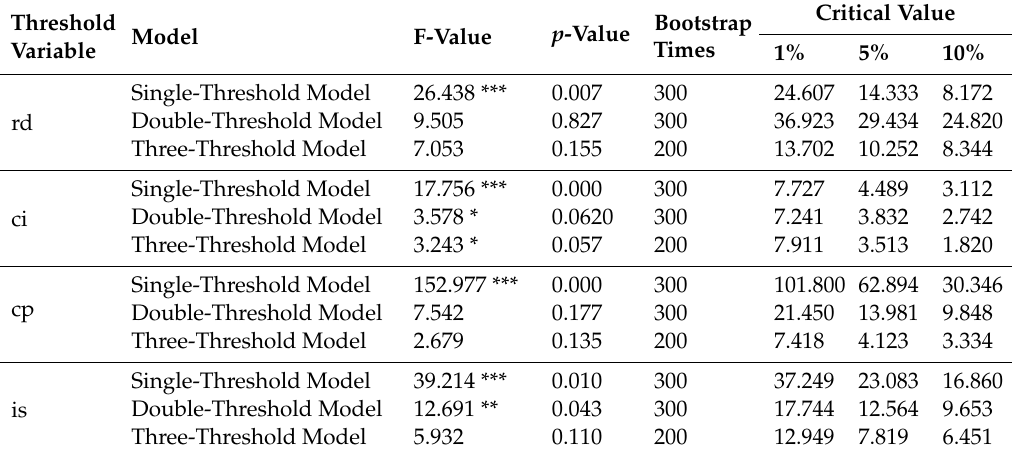
Table 3. Threshold e ff ect test results of loan size and carbon